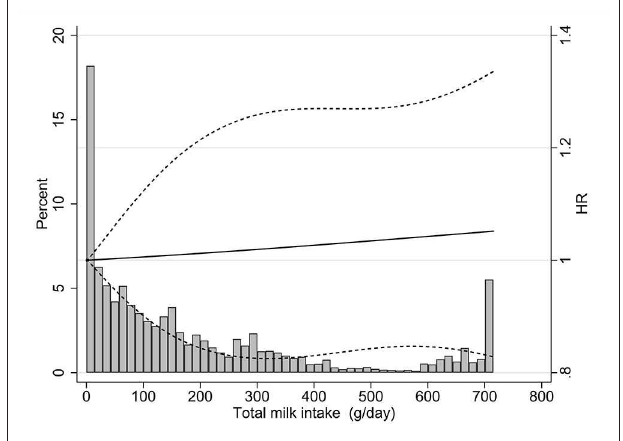
FIGURE 1 | Dose-response analysis using restricted cubic spline model for the association between total milk intake and bladder cancer risk. Solid lines represent point estimates and dashed lines represent 95% confidence intervals. The histograms show the percentage of participants (left y axis) belonging to each level of total milk